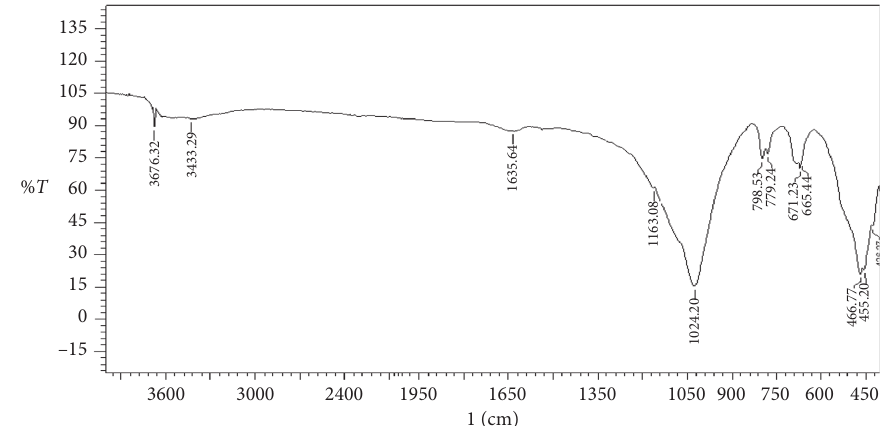
Figure 12: Infrared spectrum of the ZnO/sepiolite composite prepared by the hydrothermal reduction method.